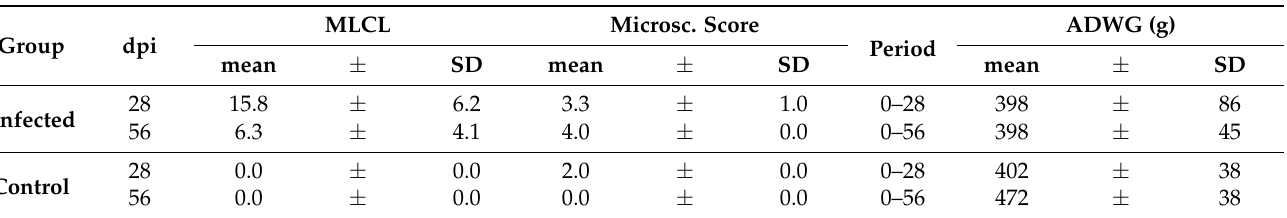
Table 1. Mean values ± standard deviation (SD) of macroscopic lung consolidated lesions (MLCL), microscopic lung lesion scores and average daily weight gain (ADWG) values according to group and day post-inoculation